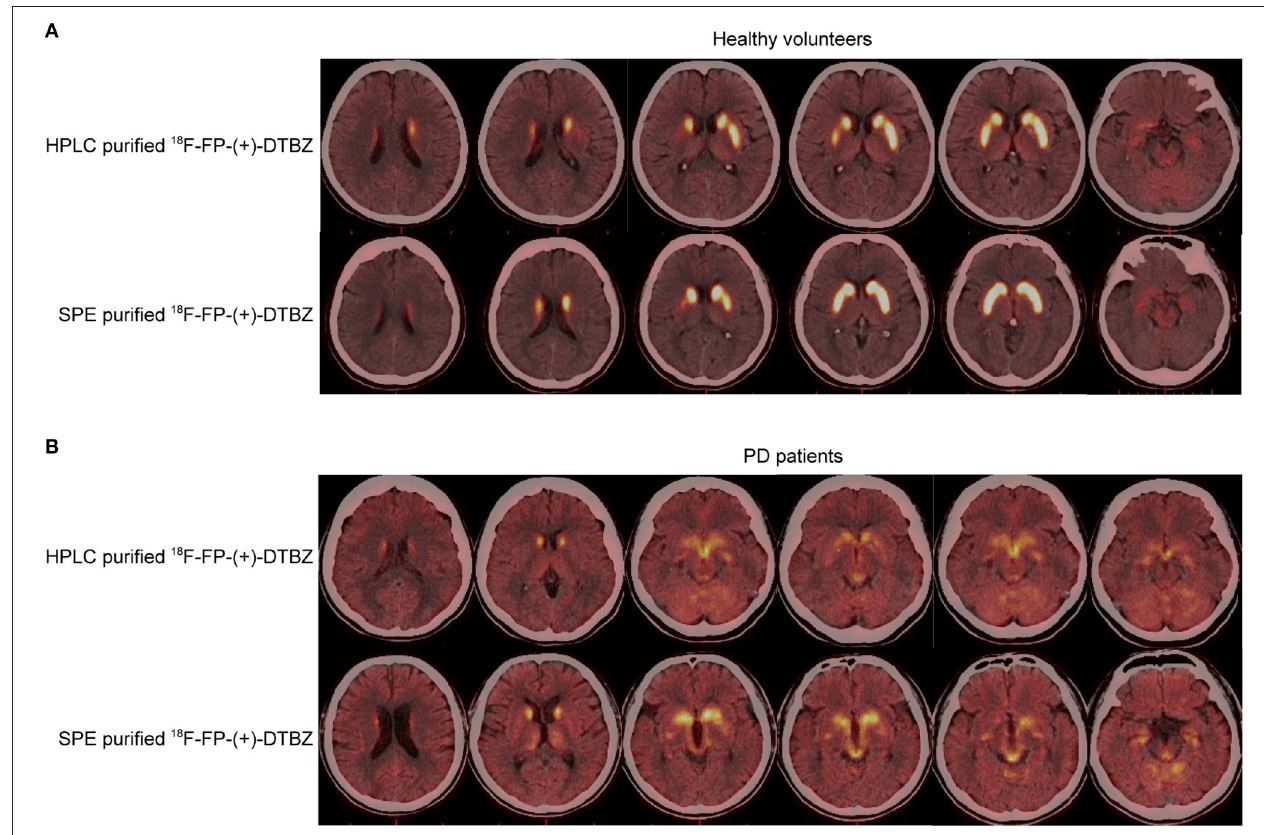
FIGURE 5 | PET/CT performance of HPLC- and SPE- purified 18 F-FP-( + )-DTBZ in healthy volunteers (A) , and PD patients (B) .